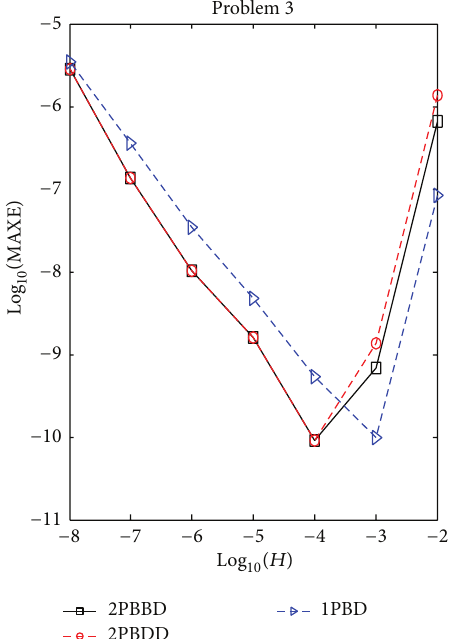
Figure 6: Graph of Log 10 ( MAXE ) plotted against Log 10 (𝐻) for Problem 3.